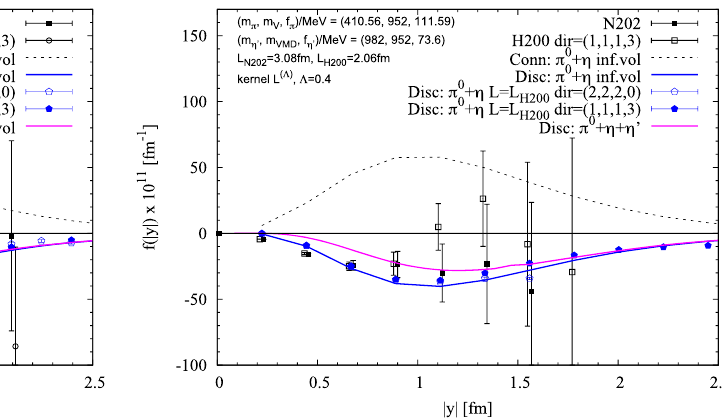
connected model prediction, the blue line the π 0 + η contribution for the disconnected and the magenta line gives the π 0 + η + η (cid:4) . The blue points show the π 0 + η contribution in finite volume